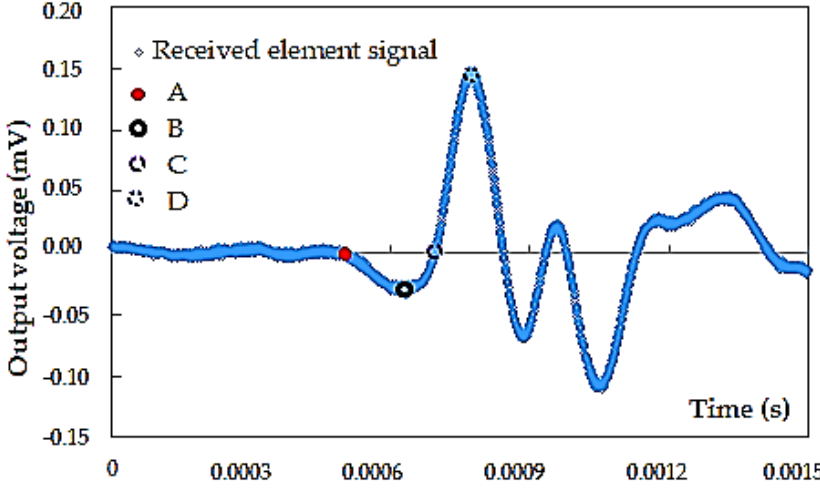
Figure 8. Receiver time charts: ( A ) the first deflection, ( B ) first bump, ( C ) zero-crossing, and ( D ) first major peak. An example of the test results from specimen S1, f = 4 kHz.